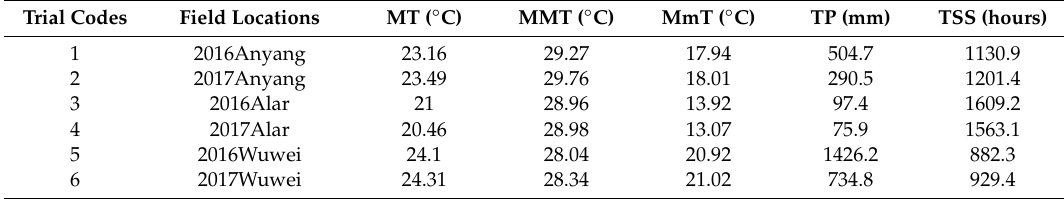
Table 2. Description of seasonal environment variables (May to October) of experimental